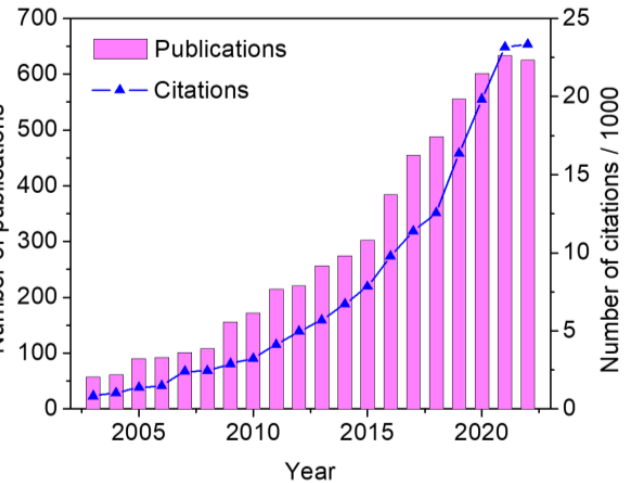
Figure 1. Report of publications and citations provided by the Web of Science database with the keywords “carbon” and “screen-printed electrode”.